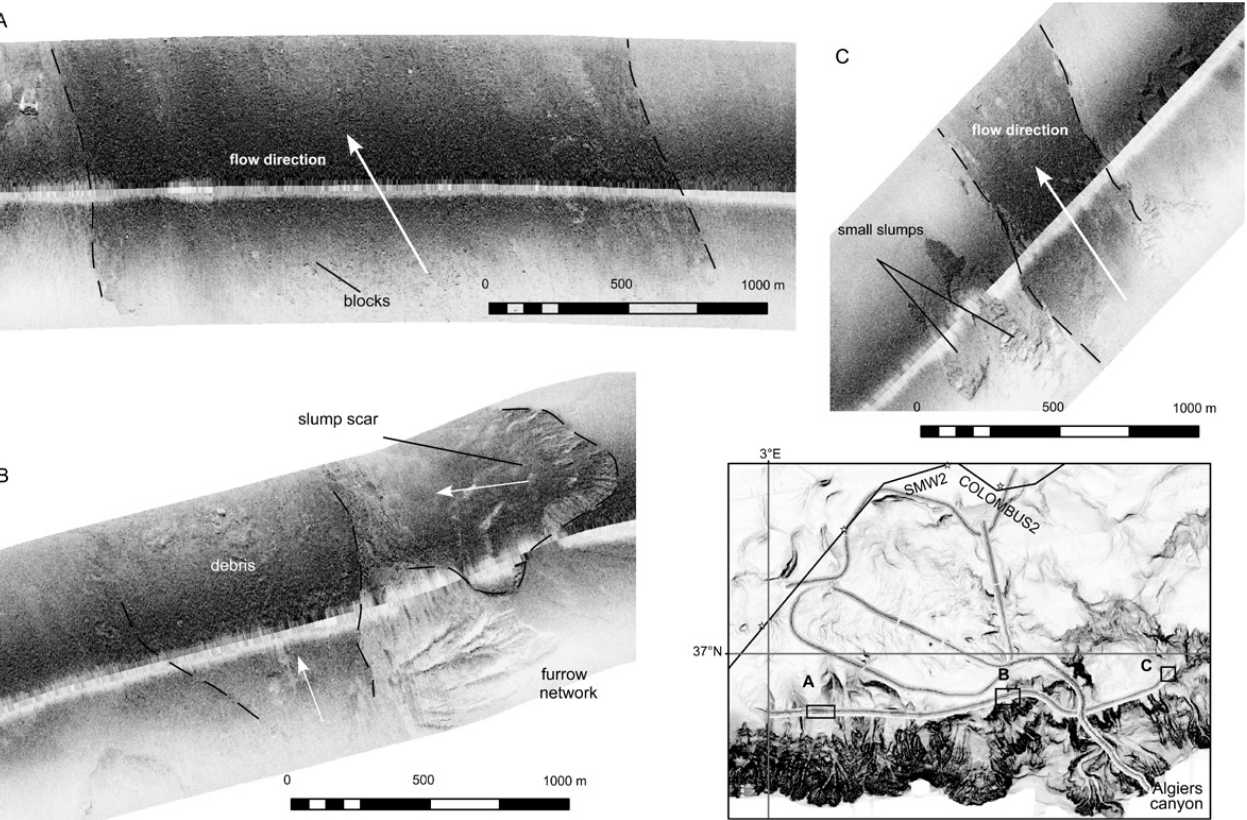
Fig. 3. Bathymetric gradient map (lower right panel) of the Algiers canyon with navigation track of side-scan sonar (SAR, light grey) and location of SMW2 (oriented SW-NE) and COLOMBUS2 (oriented W–E, U-shaped) submarine cables, where stars represent points of cable break (the map corresponds roughly to Zone 1 in Fig. 2). Three SAR images show evidence of seafloor destabilisation and erosion at the foot of the continental slope. Evidence of channelized erosion with longitudinal furrows, small sediment blocks and comet-like structures is visible in (A) and in the central part of (C) . Erosion and accumulation of debris are testified by the seafloor scars and the rough backscatter in the associated deposits in (B) and (C) (on the